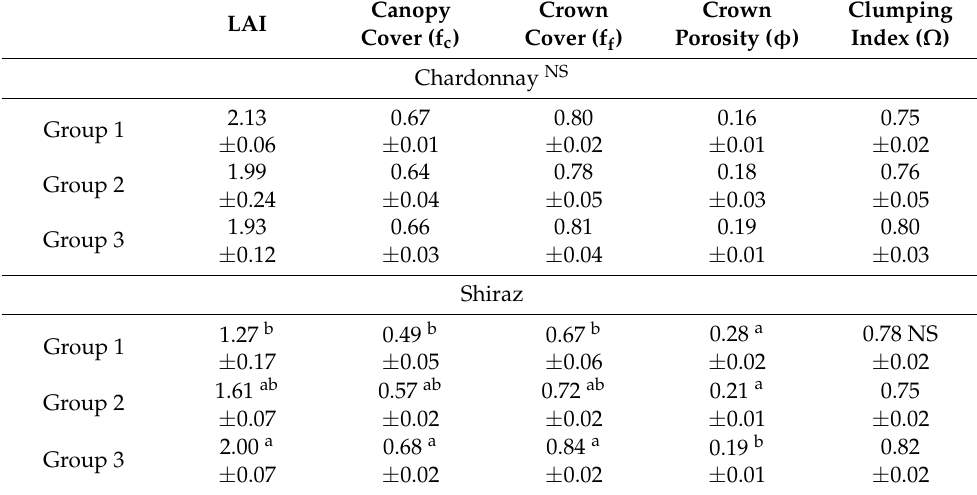
Table 2. Means (top values) and standard error (bottom values) of canopy architecture parameters of the three groups of samples of Chardonnay and Shiraz.